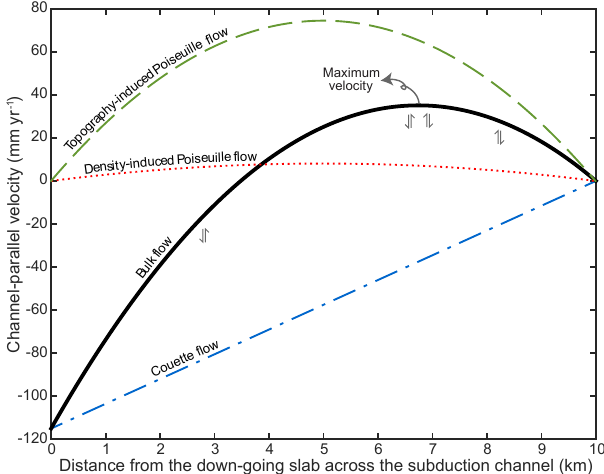
Figure 12. Velocity profile across the subduction channel filled by linear viscous material. Subduction velocity is negative and ex- humation velocity is positive. Blue dash-point line: Couette flow caused by the drag of the subducting plate; red dotted curve: Poiseuille flow driven by the buoyancy of the material in the sub- duction channel; green dashed curve: topography induced Poiseuille flow; thick black solid curve: the bulk flow of rocks in the subduc- tion channel. Note the sense of shear changes when crossing the line of maximum velocity. The duration of D2 was 2Myr for calcu- lation. See Appendix D for